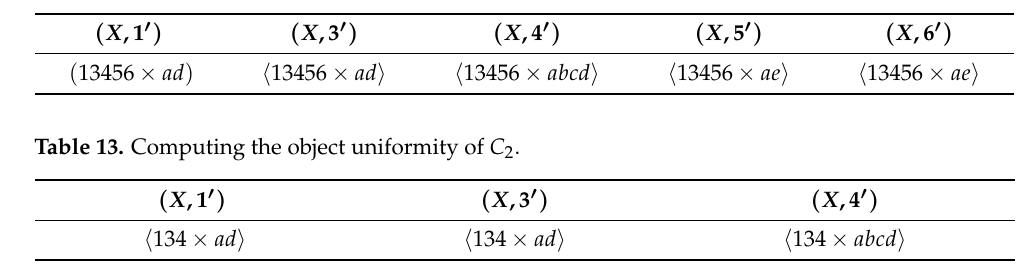
Table 12. Computing the object uniformity of C 1 .